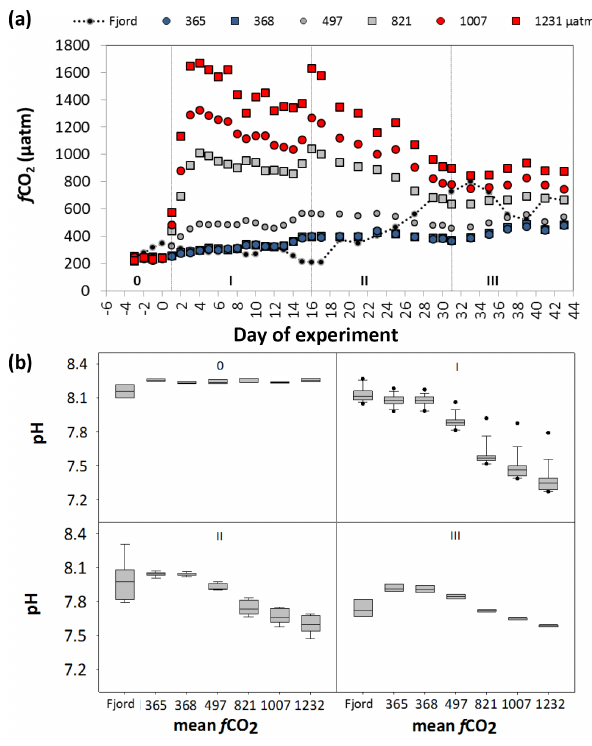
Figure 2. (a) f CO 2 values in the mesocosms and in the fjord throughout the experiment. Small black dots show the f CO 2 in the ambient fjord water. Treatment of the mesocosms with CO 2 sat- urated fjord water at the beginning of the experiment (days 0–4) created different f CO 2 levels in the mesocosms: blue symbols rep- resent the untreated mesocosms, grey the intermediate, and red the high CO 2 treated mesocosms. The treatment was repeated at day 16. (b) Corresponding pH ranges in the mesocosms during the four phases. Despite decreasing trends over time, a gradient between the mesocosms was kept over the whole period.